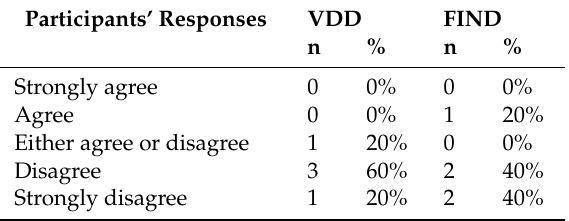
Table 11. Participants’ opinions about their expectations in spatial data discovery.